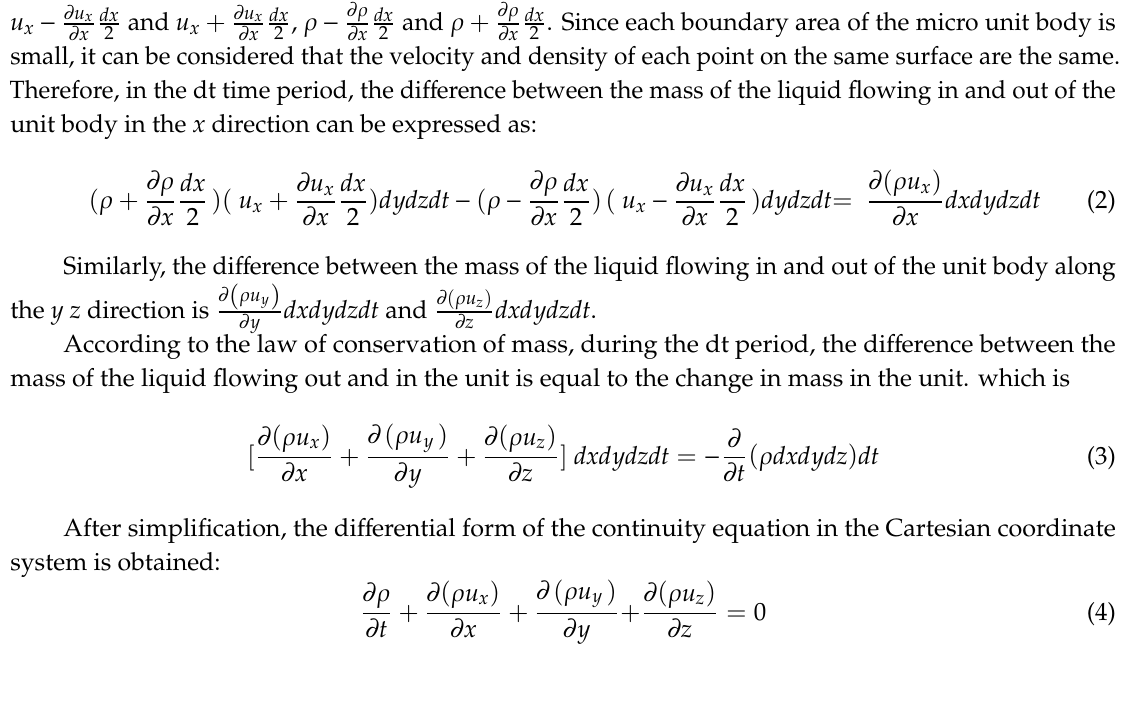
Figure 1. Schematic diagram of inflow and outflow on each face of the differential unit.